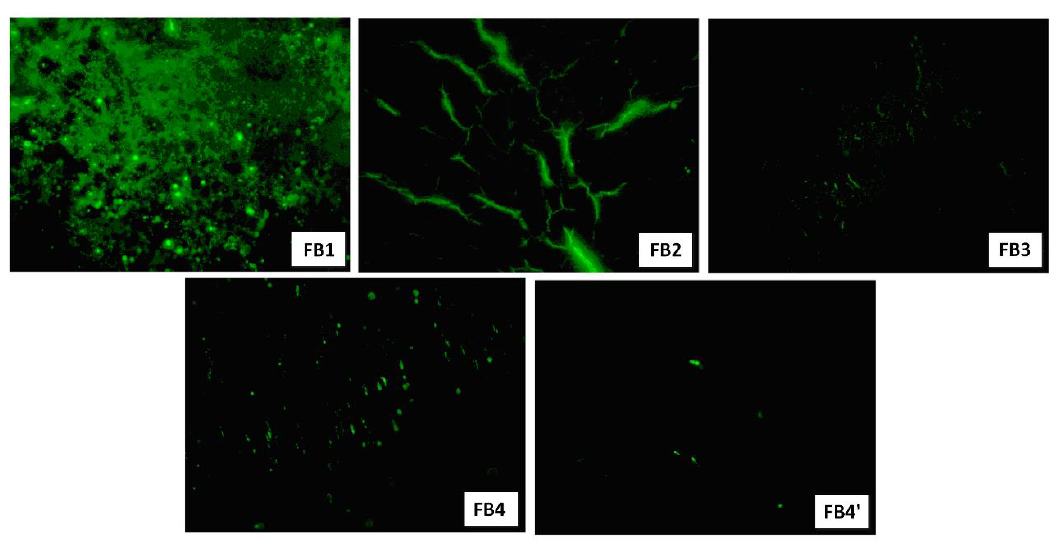
Figure 7. Evaluation of adhesive properties of polymer films FB1 – FB4 for UC MSCs (vertical scale — a number of cells in a field of view). * p < 0.05 in comparison with FB-1 .